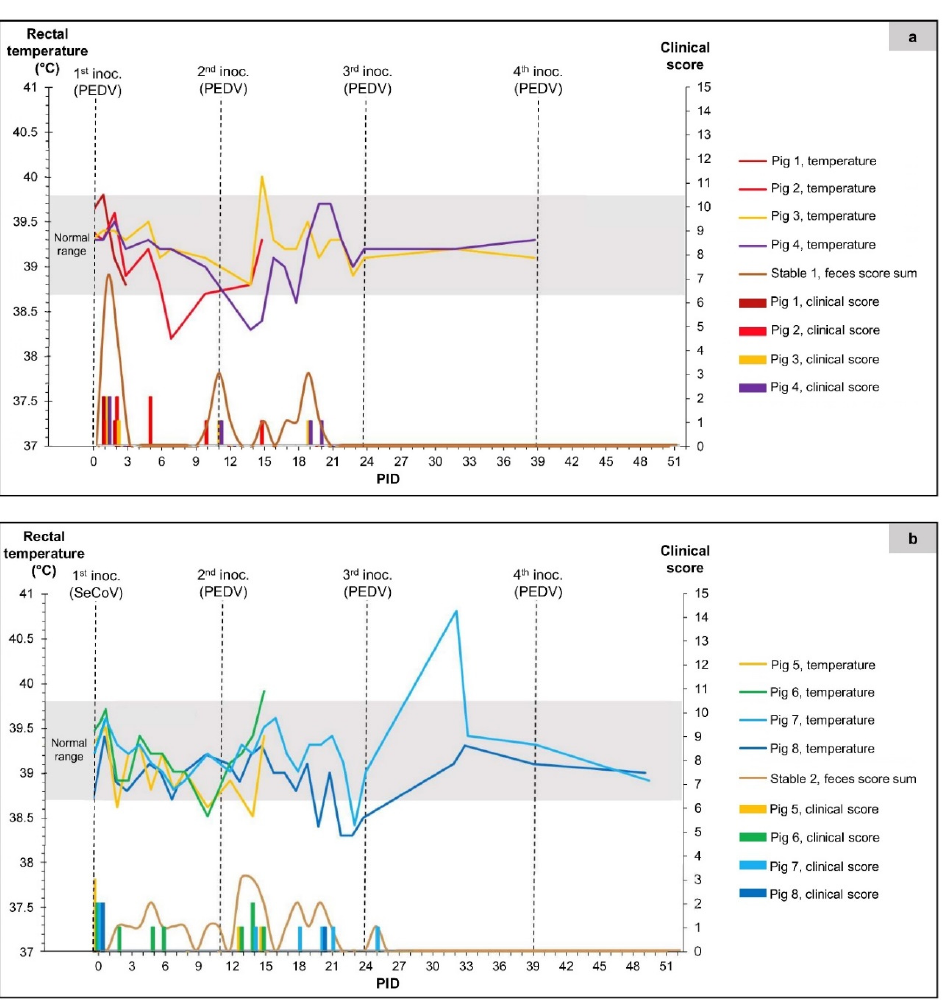
Figure 3. Clinical measurements of the pigs in group 1 (panel ( a )) and group 2 (panel ( b )). The sharp curves show the rectal temperature measurements, which were rarely measured near the end of the experiment. The grey bars indicate the normal temperature range for pigs (38.7–39.8 ◦ C). The columns show the clinical scores of the individual pigs in each group. The smooth curve shows the sum of feces scores from the individual pigs, including a score of 1 if thin/non-formed feces or diarrhea were found in the